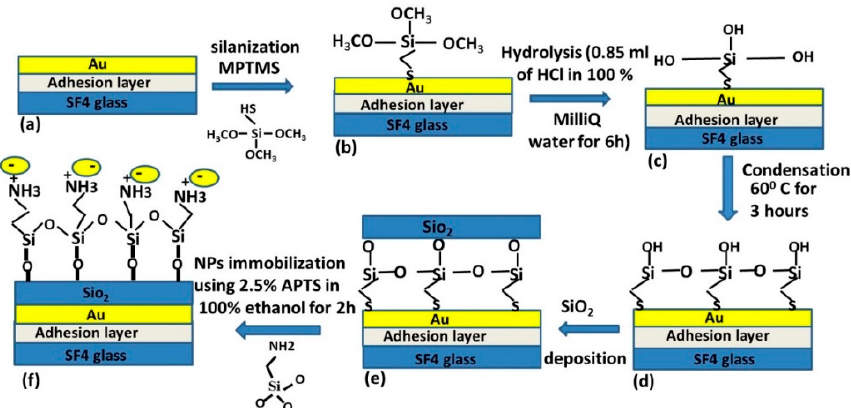
Figure 2. Schematic diagram showing the fabrication of the DLWGs. ( a ) 49 nm gold thin film deposited on clean SF4 glass. ( b ) Silanization with MPTS. ( c ) Hydrolysis process: methoxy groups are converted to Si-OH group. ( d ) Condensation leads to Si-O-Si network. ( e ) Deposition of SiO 2 and ( f ) modification of SiO 2 with amino group’s (-NH 2 ) of APTS, which serves as molecular link for the negative charged citrate stabilized AuNPs.